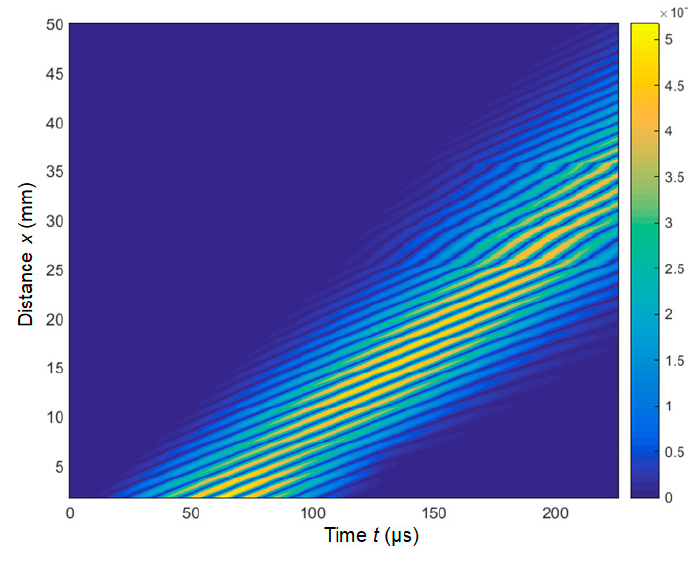
Figure 12. The positions of those non-uniformities in Figure 16 are denoted by the red vertical lines. Variations of the phase velocity in those regions reach 95–117 m/s. The largest values of the phase velocity correspond to the darker non-uniformities with higher values of the Young’s